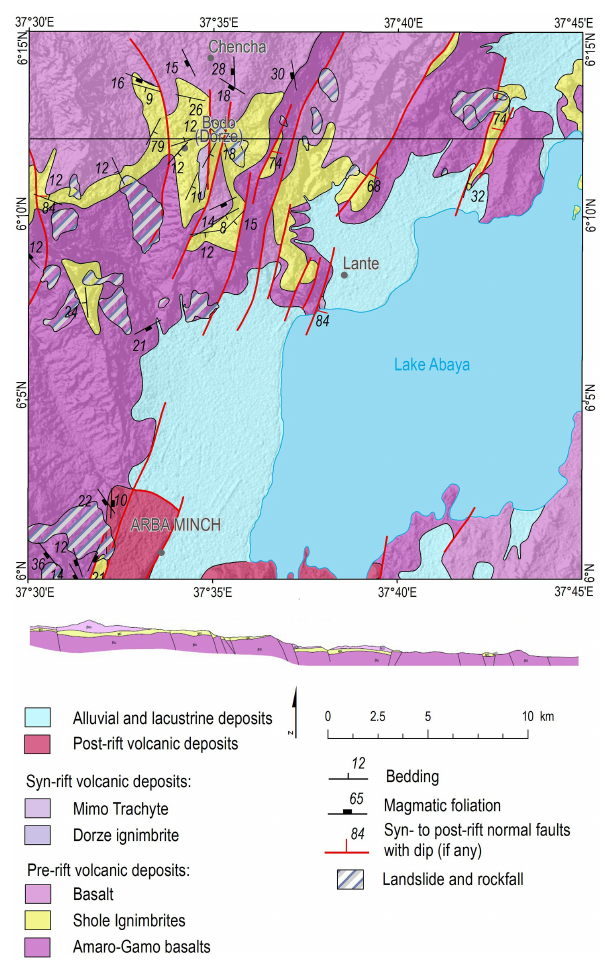
Figure 11. Geological and tectonic map of the Arba Minch site, with landslides and rockfalls indicated. For the location, see Fig.